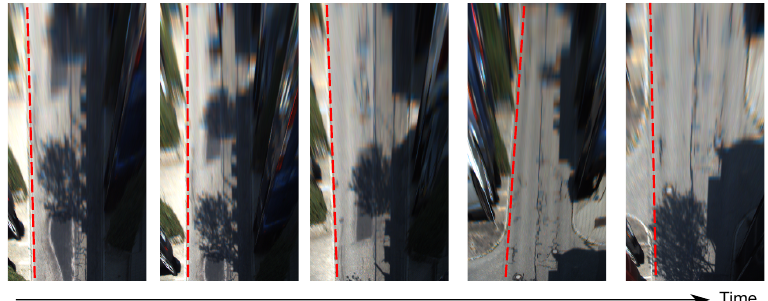
Figure 3. IPM images with the constant ground plane normal: road edges are not properly